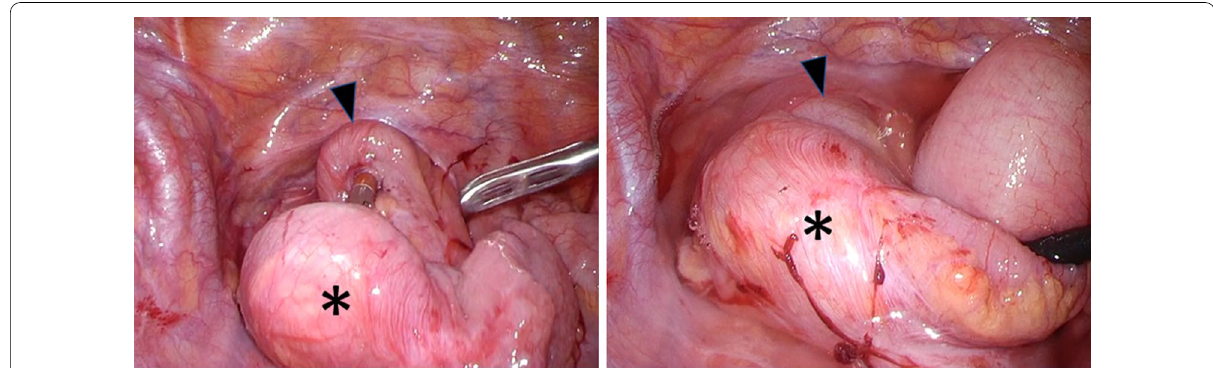
Fig. 8 Laparoscopic partial resection of the rotated small and pouch-ileum reanastomosis was performed for recurrent volvulus. *: Oral side of the ileum, black down-pointing triangle: Anterior wall of the pouch